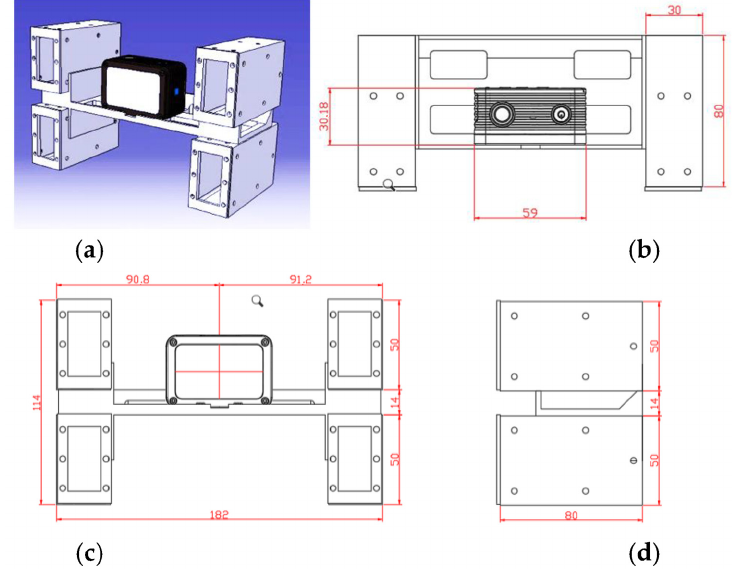
Figure 7. Structural dimensions of the camera and laser ranging modules: ( a ) three-dimensional image; ( b ) top view; ( c ) front view; ( d ) left